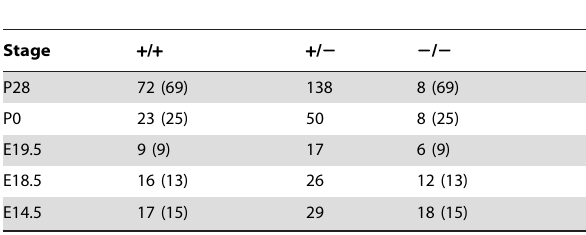
The total number of embryos or postnatal mice isolated for each genotype is indicated, with values in parentheses indicating the number of embryos or postnatal mice expected based on Mendelian distribution.